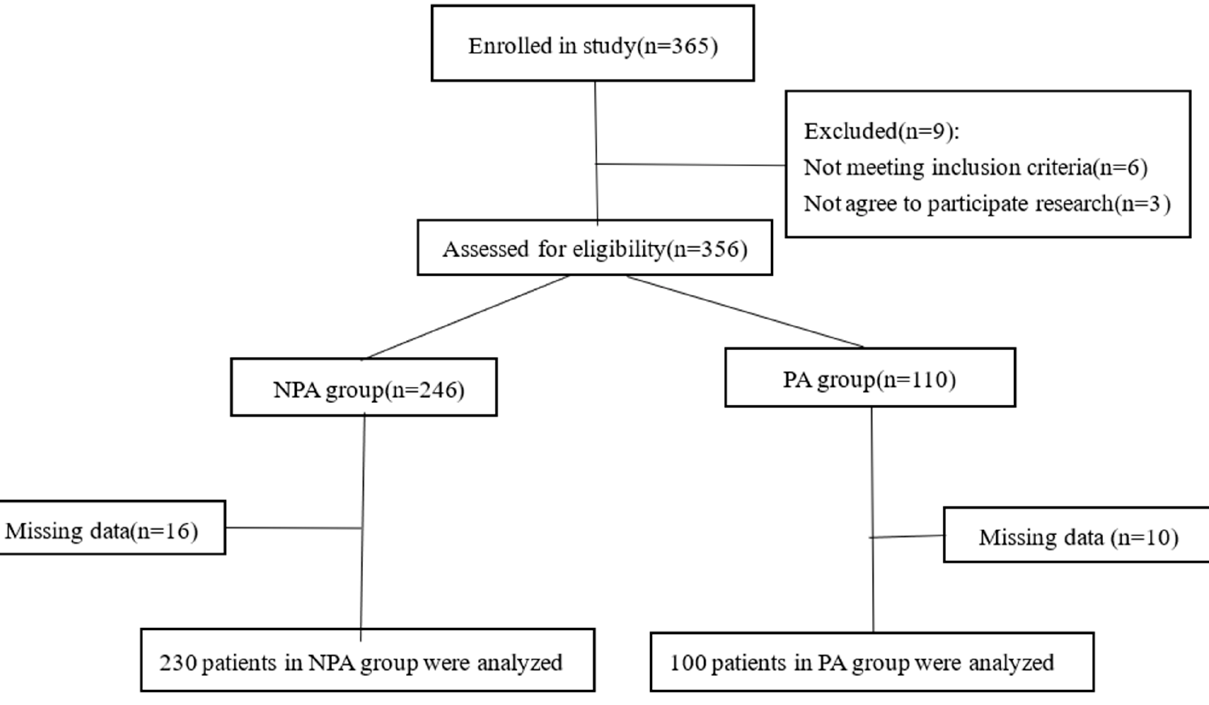
Figure 1. Study flowchart.